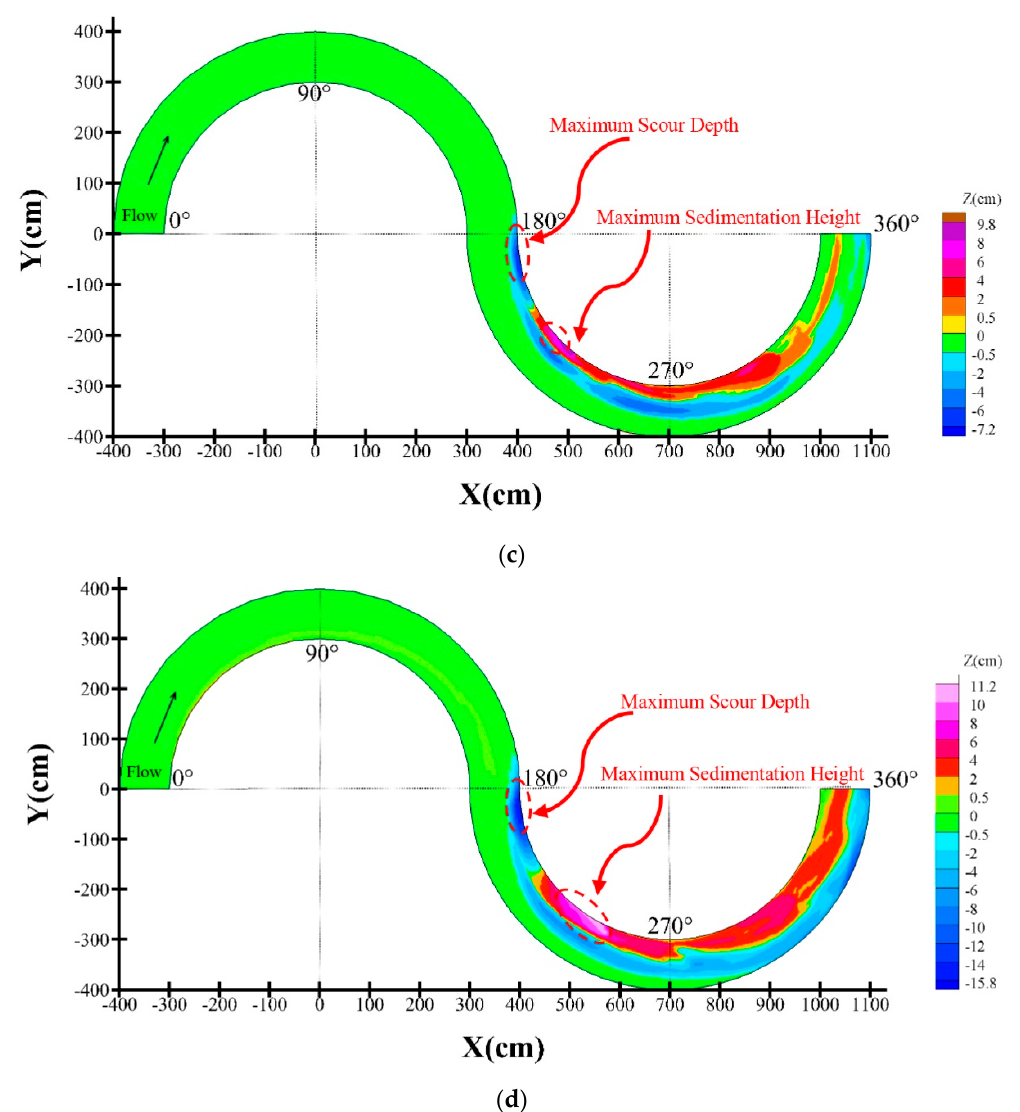
Figure 4. Bed topography variations for different U/Uc values: ( a ) 0.89, ( b ) 0.92, ( c ) 0.95, and ( d )